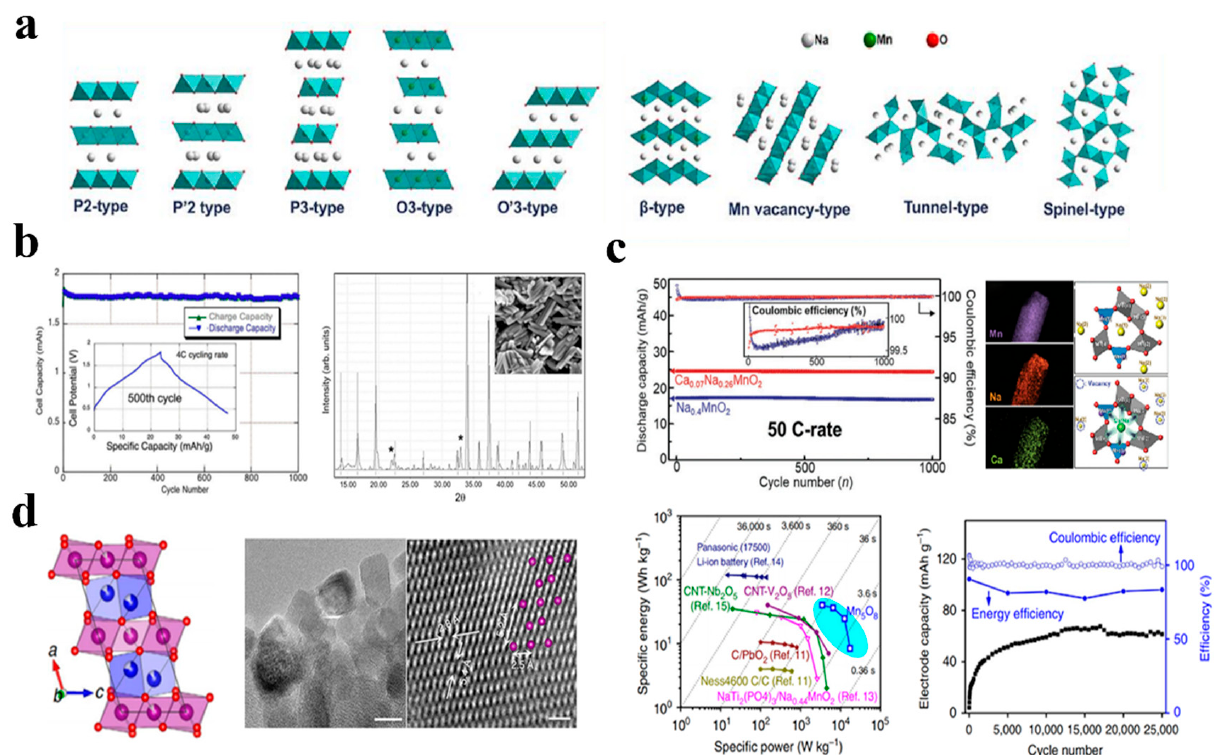
Figure 6. ( a ) A schematic diagram of the crystal structures for NaxMnO 2 . Reproduced with the per- mission of ref. [67], copyright 2020 American Chemical Society ( b ) The demonstration of Na 4 Mn 9 O 18 and full cell characteristics which "*" represents the inert Mn 2 O 3 . Reproduced with the permission of ref. [70], copyright 2010 Elsevier B.V. ( c ) Comparison of Na 0 . 4 MnO 2 and Ca 0 . 07 Na 0 . 26 MnO 2 . Repro-